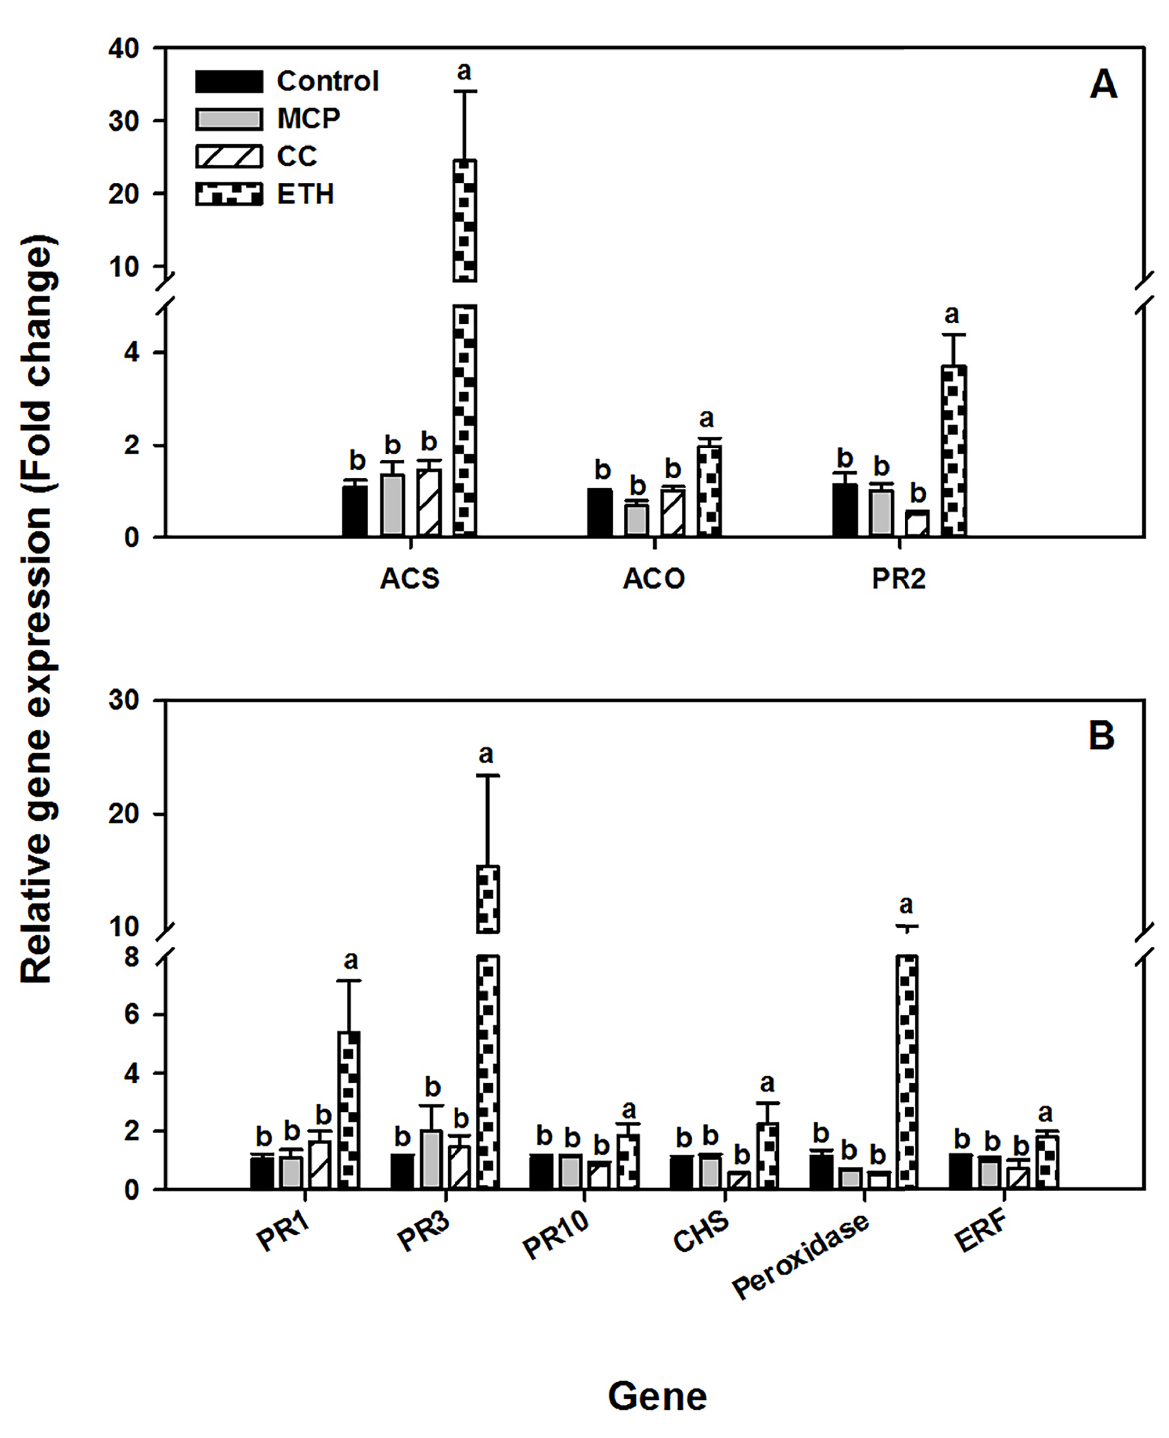
Fig 5. Effect of chemical treatment on defense gene expression in Williams 82. Expression analysis of soybean genes twenty-four hours after exposer to water (control), 1-methylcyclopropene (MCP), cobalt chloride 1mM (CC), or ethephon 4mM (ETH) in the moderately susceptible cultivar Williams 82. (A) Genes involved in ethylene biosynthesis and signaling, 1-aminocyclopropane-1-carboxylic acid synthase ( ACS ), 1-aminocyclopropane-1-carboxylic acid oxidase ( ACO ), and β -1,3-endoglucanase ( PR2 ), (B) defense-related genes, pathogenesis-related protein 1 ( PR1 ), Chitinase class I ( PR3 ), Intercellular pathogenesis-related protein 10 ( PR10 ), Chalcone synthase ( CHS ), basic peroxidase ( Peroxidase ), and ethylene response factor 1 ( ERF1 ). Soybean seedlings were drenched with water (control), ethephon 4 mM, cobalt chloride 1 mM, or foliar sprayed